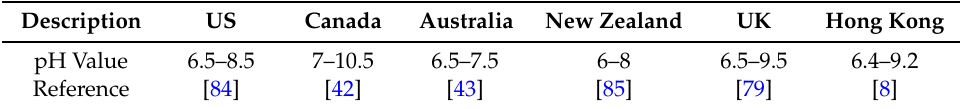
Table 8. Drinking water pH